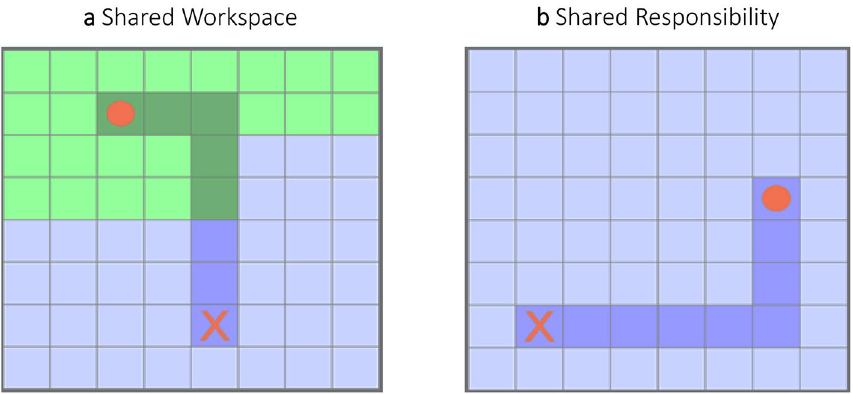
Figure 1. Collaboration scenarios: ( a ) Shared workspace scenario where the workspace is divided into two areas, and each actor can control the object movements only over one area—either colored in green or blue. This scenario simulates collaboration on the same task with object hand-over between a human and an agent; ( b ) Shared responsibility scenario where both actors control the movement of the object in only two directions (e.g. only up and left) out of the four possible directions (up, down, left, and right). This scenario simulates collaboration on the same task, where both the human and the agent physically and sequentially interact with the object at the same time. The background was randomly switching between green and